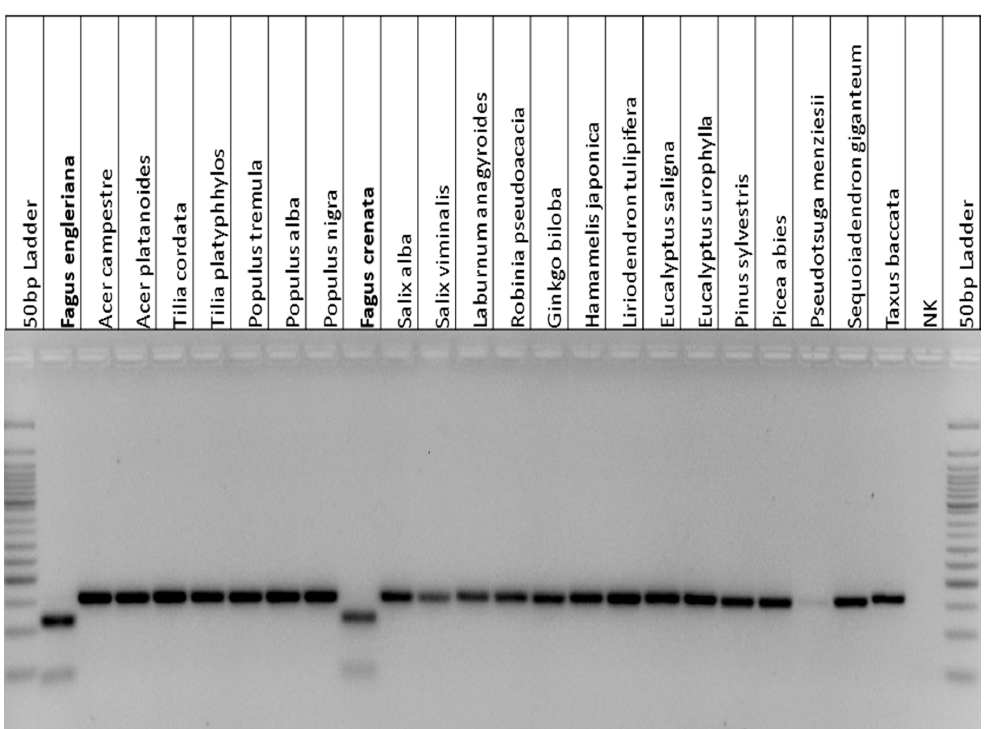
Figure 2. Pre-validation of the Fagus -specific mitochondrial CAPS marker 3_Fagus_ ccmFc (marker